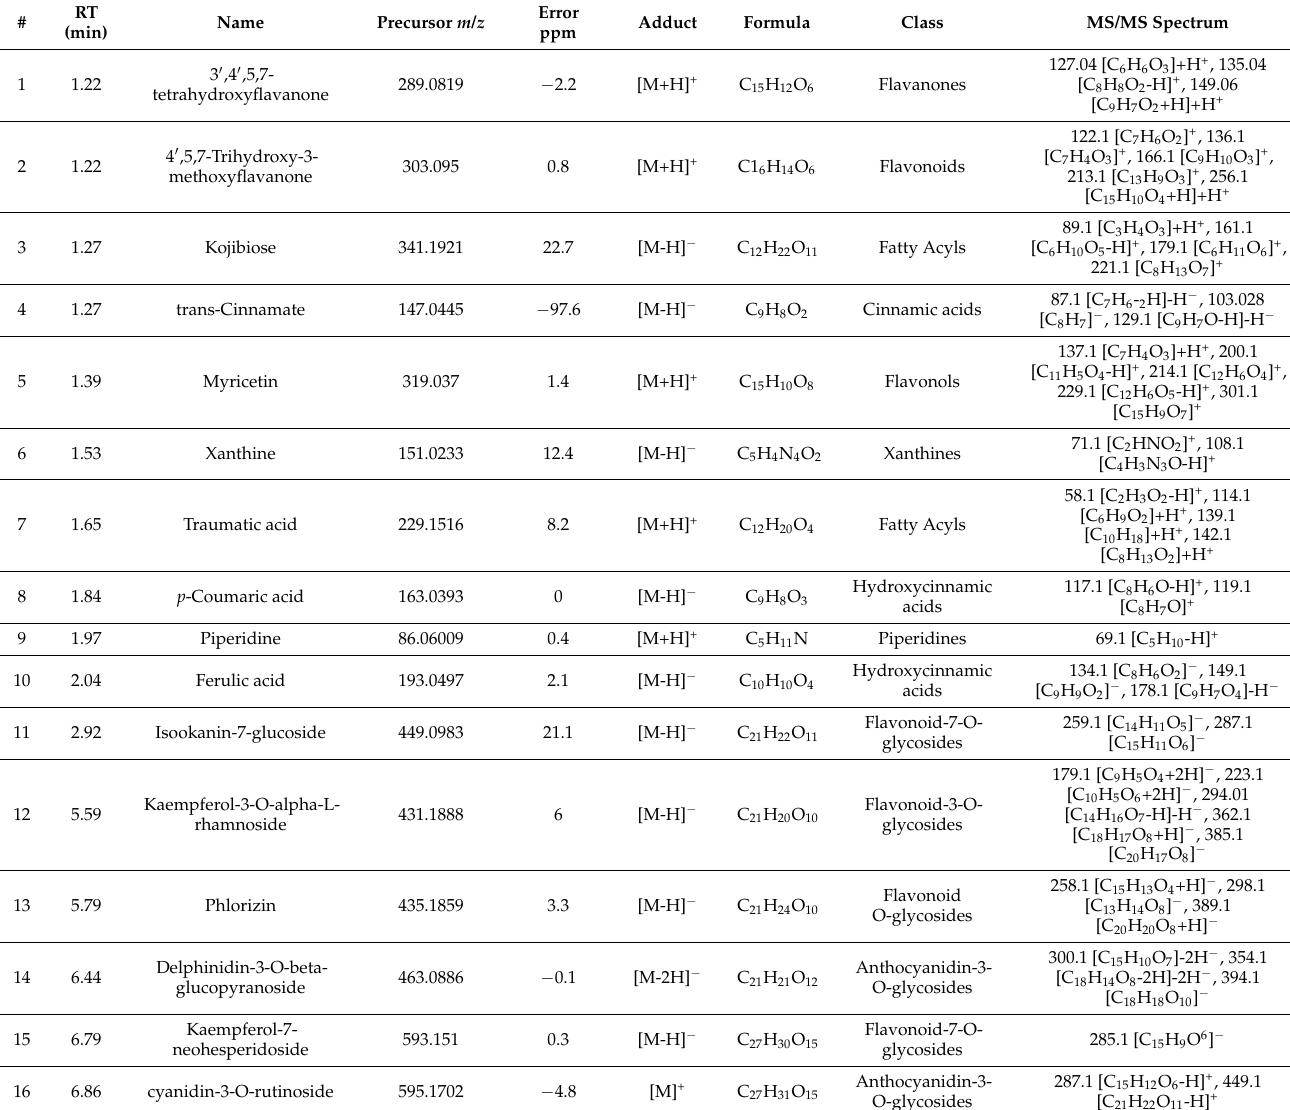
Table 1. List of identified metabolites in both positive and negative